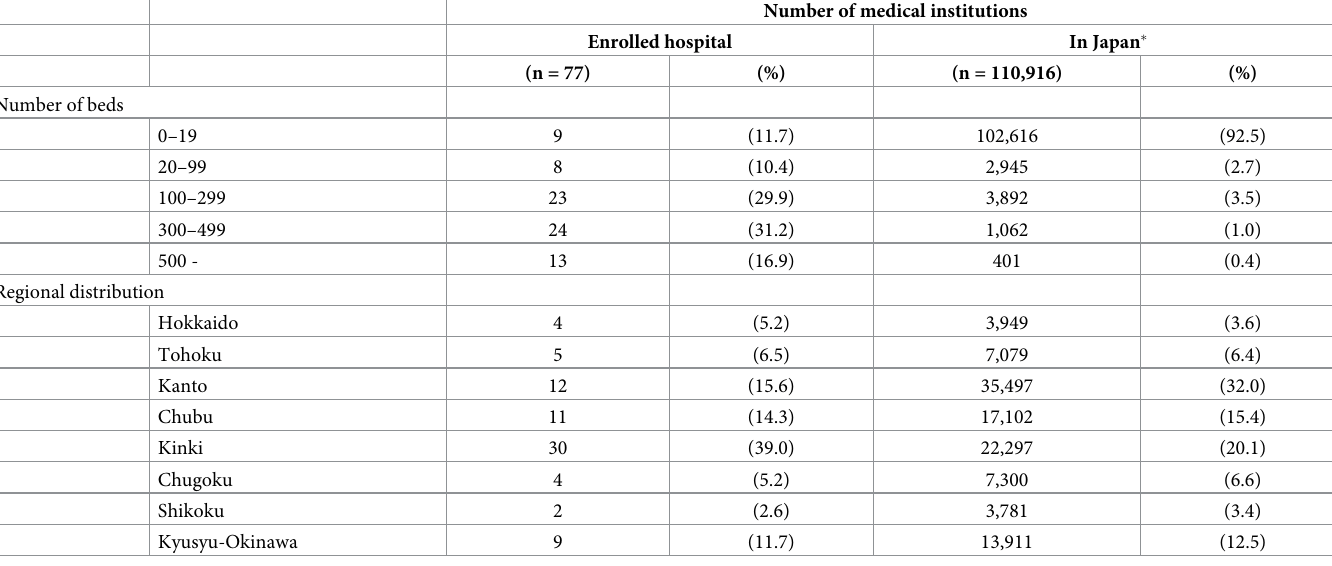
Table 1. Characteristics of medical institutions included in the study compared to those at the national level in